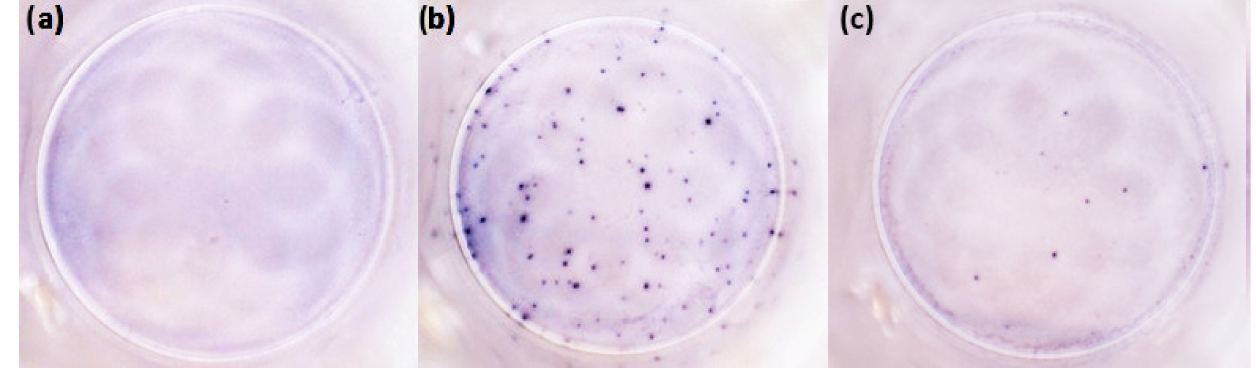
Figure 1. The evaluation of the T-Spot test: ( a ) negative; ( b ) positive; ( c ) borderline